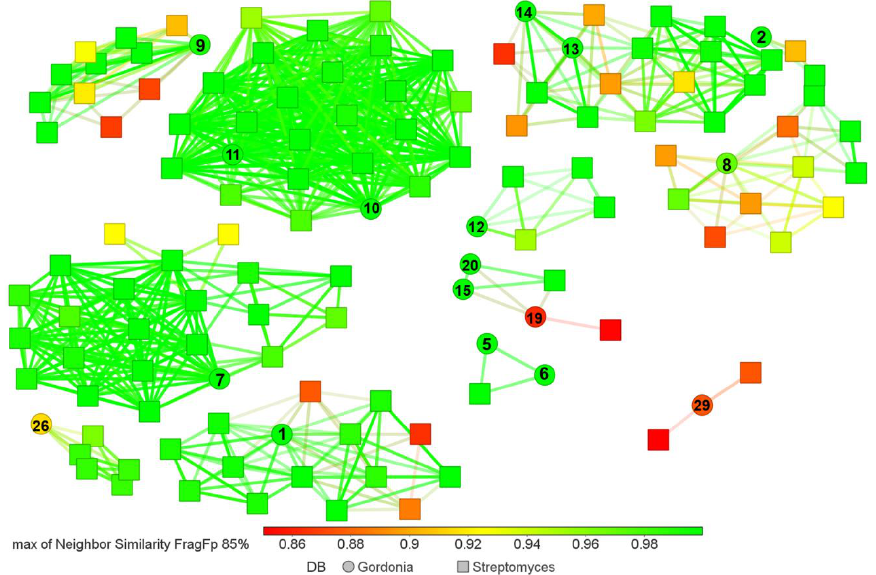
Figure 4. Similarity chart between Gordonia -derived compounds and Streptomcyes -derived com- pounds. The similarity between compounds was measured using the FragFp descriptor. The dots represent compounds derived from Gordonia, and the squares indicate those metabolites derived from Streptomyces (obtained from StreptomeDB v3.0 [58]). The color scale bar indicates the level of similarity from red (0.85) to green (1.00).